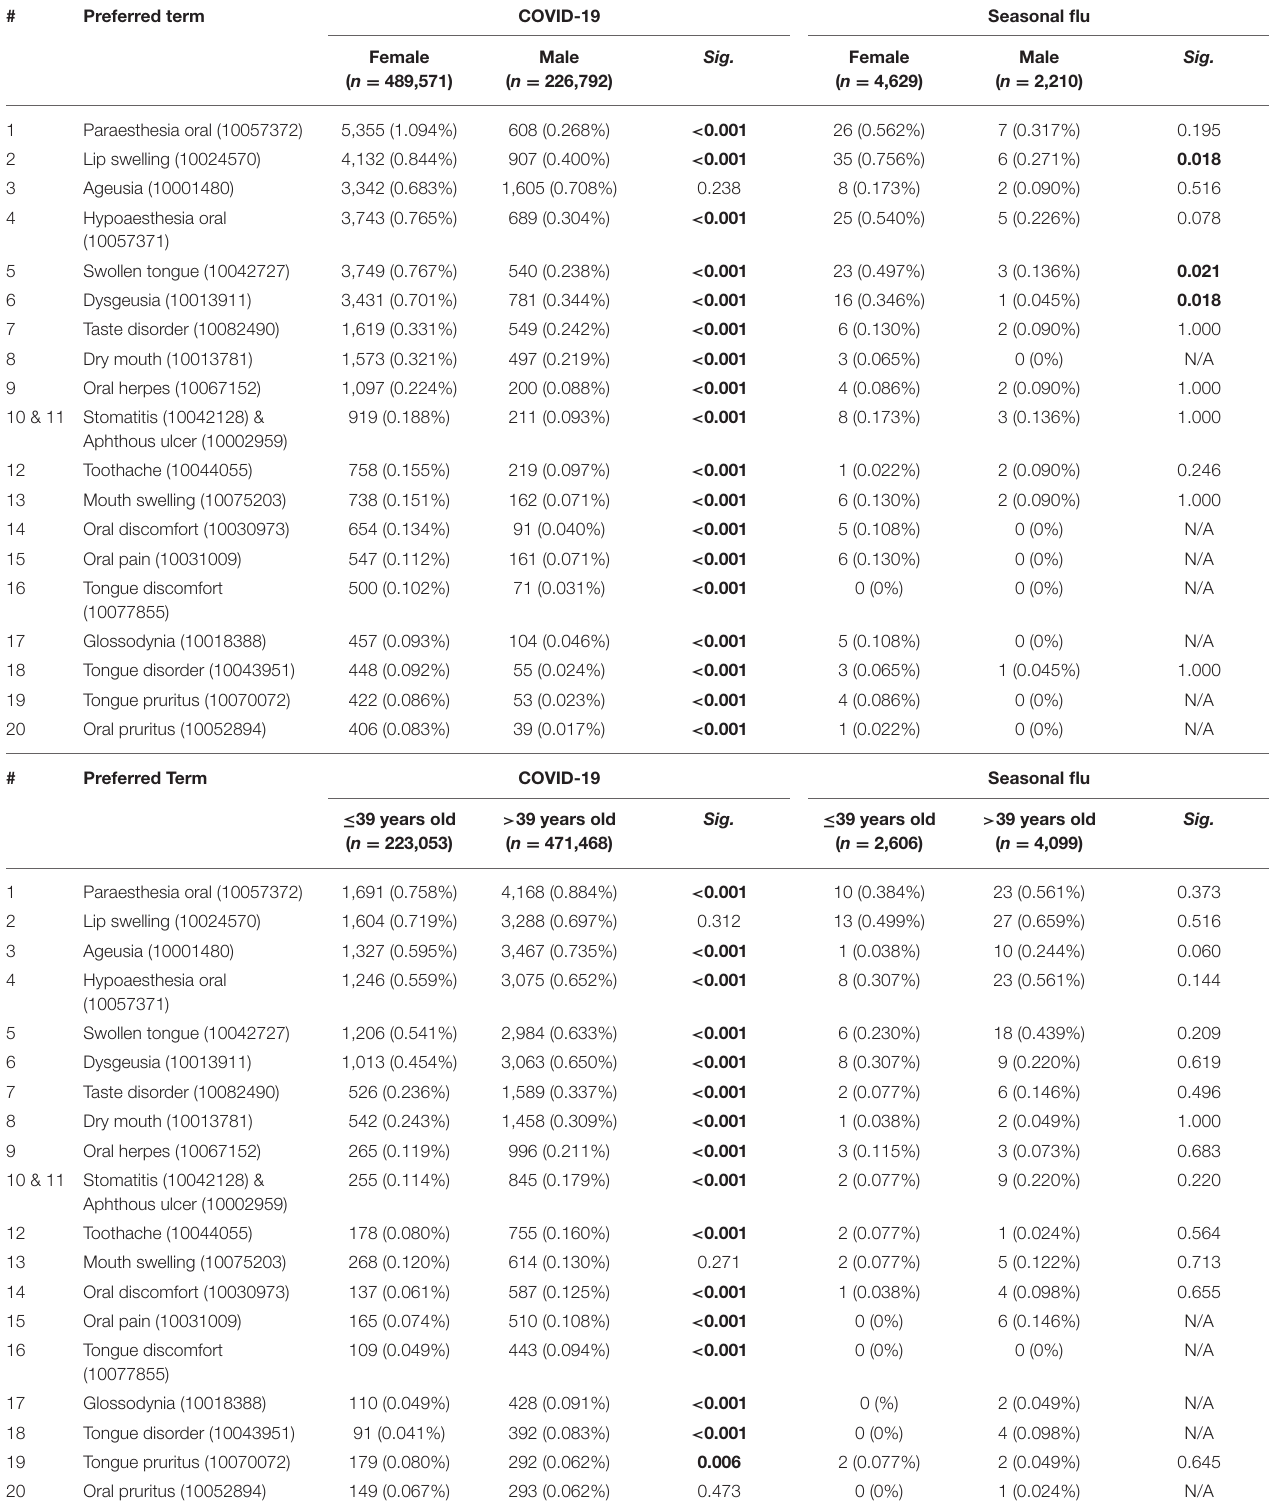
TABLE 3 | Top twenty oral adverse events reported after COVID-19 and seasonal influenza vaccines in the United States stratified by sex and age group, January–December 2021 (CDC;